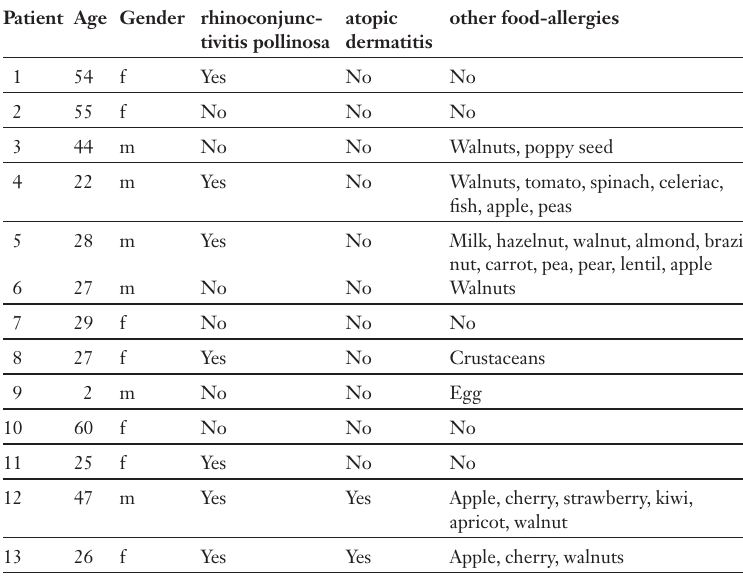
Case histories in regard to atopic diseases and allergies to other foods, age and gender of included patients (n =